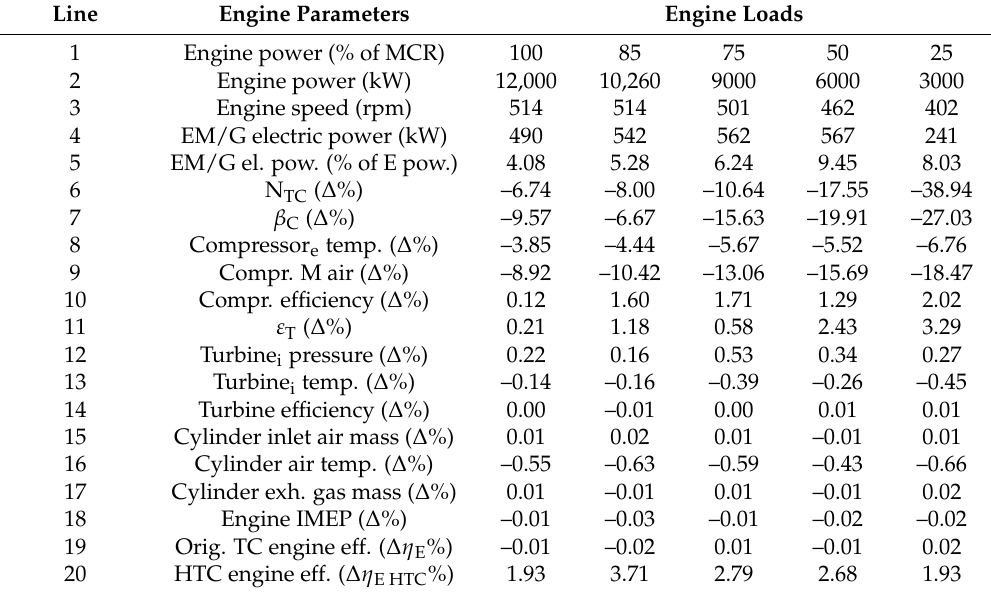
Table 3. Conventional and hybrid turbocharger comparison for different engine working points and variable speed.